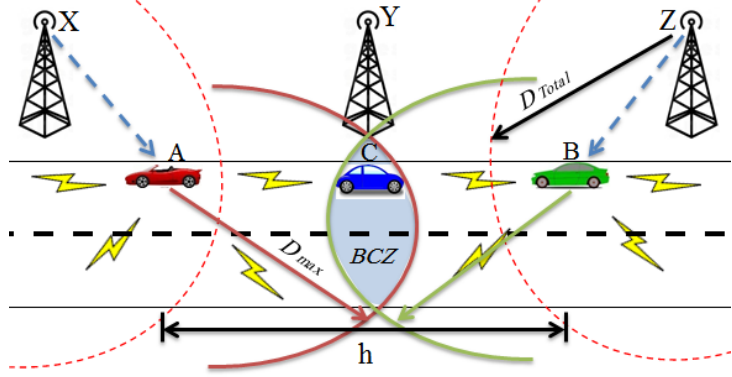
Figure 2. BCZ area of two vehicles located in different RSUs coverage